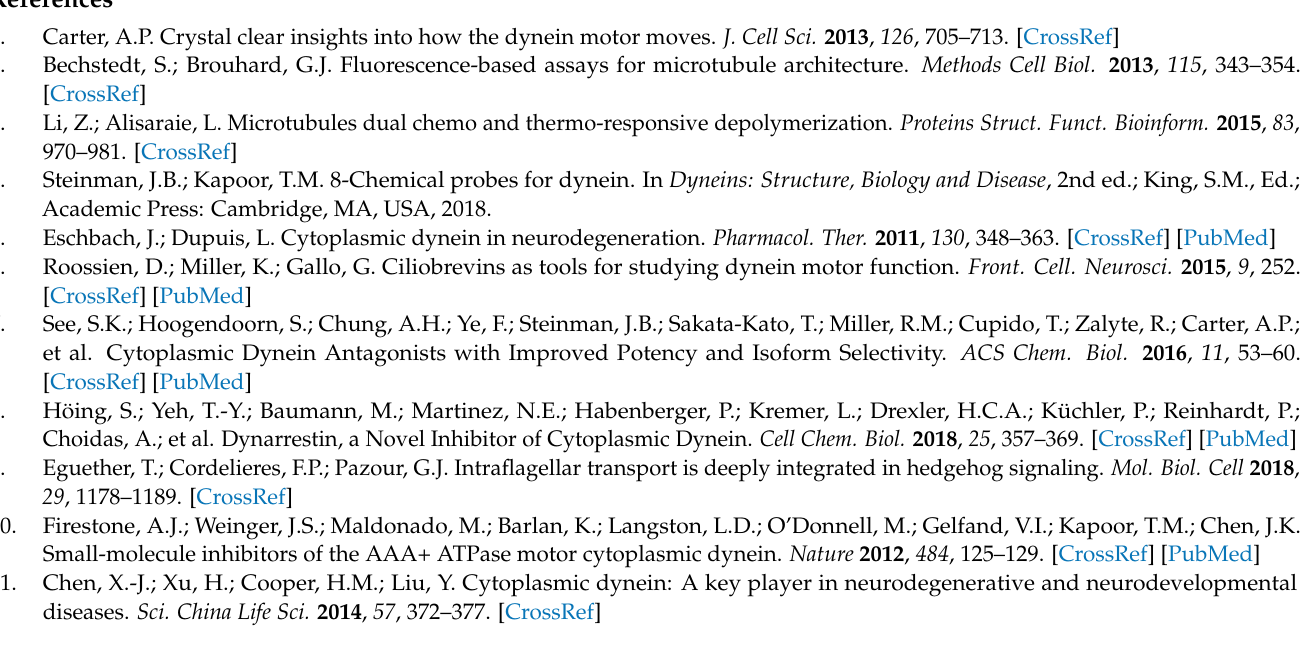
on ATP. (C) Analogue 42. (D) Analogue 42 superimposed on ATP. (E) Analogue 38. (F) Analogue 38 superimposed on ATP. Superimposition of (G) analogues 42 and 45, (H) analogues 38 and 45, and (I) analogues 38 and 42; Figure S7. Intramolecular interactions between the catalytic residues at the AAA1 binding site and Arg1852 involving a potential glutamate switch. The docking solution of AMPPNP is represented in green sticks. Thr1803 and Asp1848 accommodate Mg 2+ during ATP hydrolysis. Sensor I (N1899), W-B (E1849Q), and R-finger (R2209) play catalytic roles during ATP hydrolysis; Figure S8. E and Z configurations of ciliobrevin D. Red arrows point to the double bond between the C8 and C11 atoms; Figure S9. Binding modes of the protonated forms of ciliobrevin at the AAA1 binding site of dynein 1. (A) Ciliobrevin A protonated at the N9 atom. (B) Ciliobrevin A protonated at the N9 atom superimposed on ciliobrevin A. (C) Ciliobrevin A protonated at the N7 atom. (D) Ciliobrevin A protonated at the N7 atom superimposed on ciliobrevin A. (E) Ciliobrevin D protonated at the N9 atom. (F) Ciliobrevin D protonated at the N9 atom superimposed on ciliobrevin D. (G) Ciliobrevin D protonated at the N7 atom. (H) Ciliobrevin D protonated at the N7 atom superimposed on ciliobrevin D; Figure S10. Main binding interactions of the protonated forms of dynapyrazole B at the AAA1 binding site of dynein 1. (A) Dynapyrazole B protonated at the N7 atom. (B) Dynapyrazole A protonated at the N7 atom superimposed on dynapyrazole B. (C) Dynapyrazole B protonated at the N9 atom. (D) Dynapyrazole B protonated at the N9 atom superimposed on dynapyrazole A. (E) Dynapyrazole B protonated at the N11 atom. (F) Dynapyrazole B protonated at the N11 atom superimposed on dynapyrazole B; Table S1. Networking interactions of analogues 28, 29, and 30 with AAA1 of dynein 1; Table S2. Interacting amino acids with analogues 38, 42, and 45; Table S3. The binding energy of E and Z isomers of ciliobrevin A and ciliobrevin D; Table S4. Interacting amino acids with dynapyrazole A and B in the protonated and deprotonated